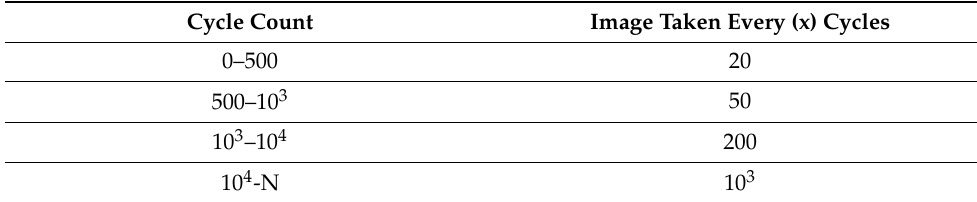
Table 4. DIC image acquisition frequency for the fatigue